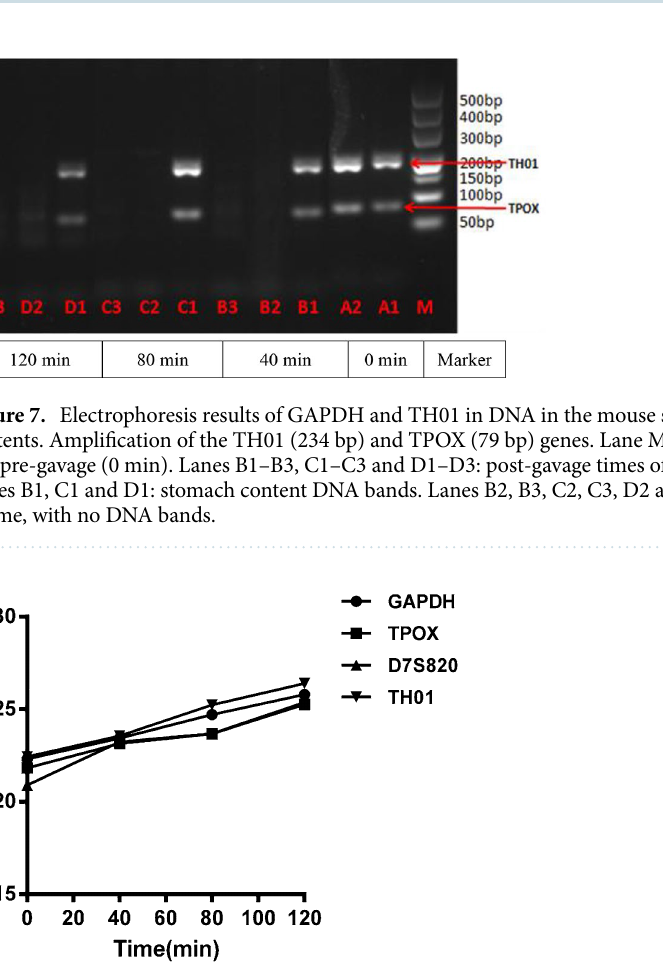
Figure 8. Ct values of four target genes at various times.